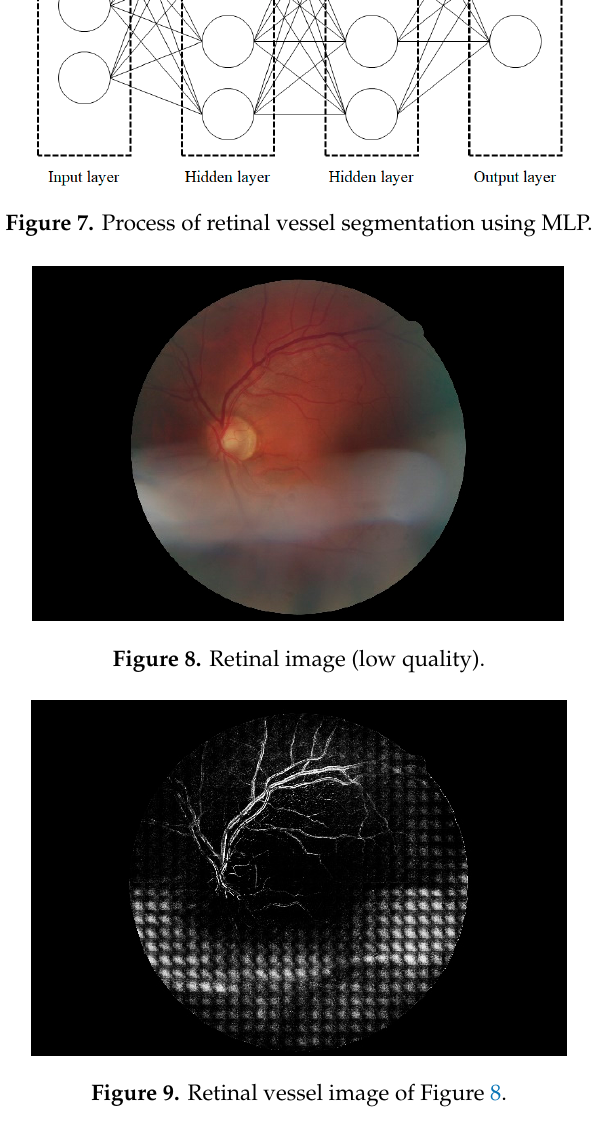
Figure 9. Retinal vessel image of Figure 8.